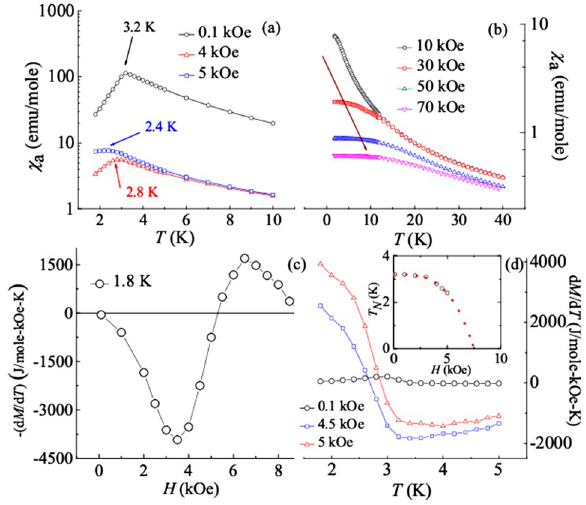
Figure 1. ( a,b ) χ a as a function of temperature at different applied magnetic fields. In ( a ) the arrows represent transition temperature ( T N ) at various fields whereas in ( b ) the arrow shows the temperature corresponding to the saturation of χ a ( T ). ( c ) H response of the thermodynamic quantity − (d M /d T ) at 1.8 K, showing a sign change just above 5 kOe. ( d ) T dependence of d M /d T at various applied external magnetic fields. The inset shows the behavior of T N as a response to the applied field. Red dashed line corresponds to the power law